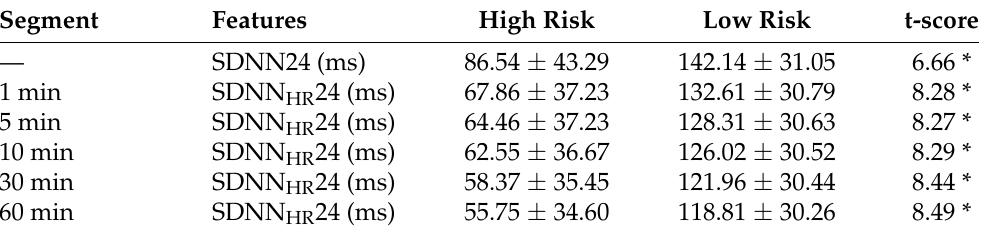
Figure 2. Power spectrum density plot obtained by Lomb-Scargle Periodogram in both low and high cardiovascular risk subjects. Table 5. Difference between people with low and high cardiovascular risk in all the segments